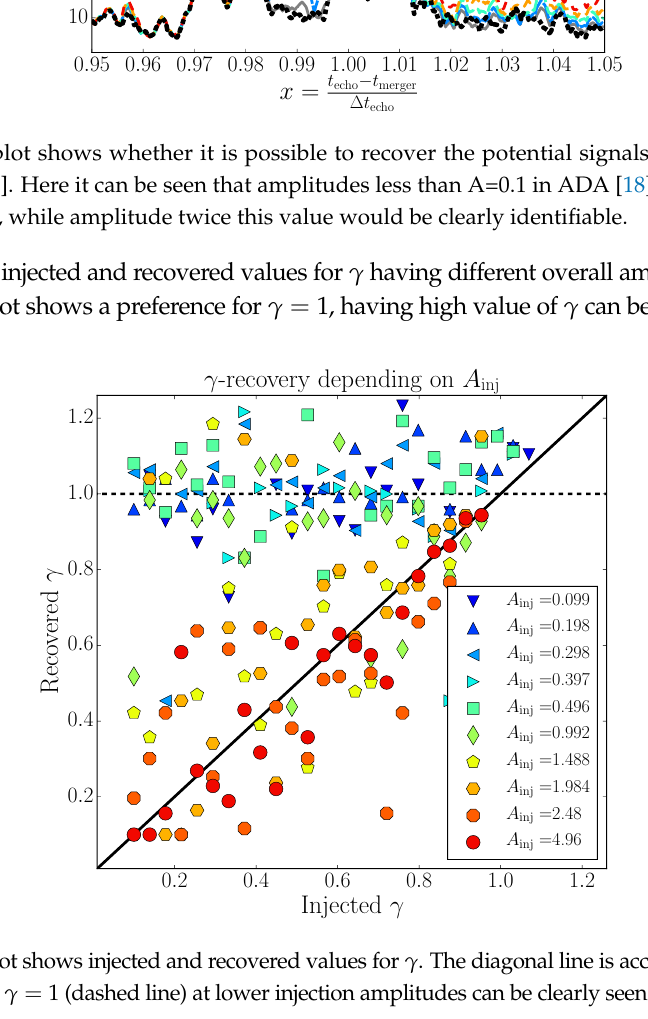
FIG. 4. Injections of echo signals into Gaussian noise are anal- ysed for different amplitudes of the injection. For injections with amplitudes above 10 − 22 of peak strain, the recovered values are close to the injected ones, indicated by the diago- nal line. For injections with lower amplitudes, the recovered amplitudes are around 10 − 22 , independently of the injected value. The amplitudes found in [20] are shown as horizontal lines (“true” values unknown) and are similar to the values incorrectly recovered for low amplitudes. The shown injec- tions are made with γ = 0 . 8, with similar results for other values.